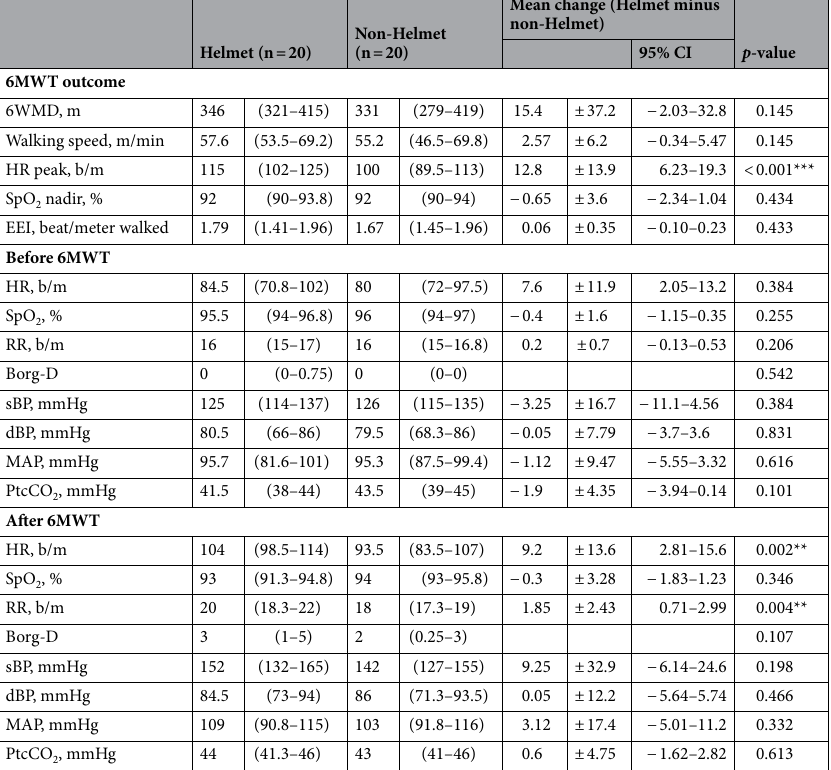
Table 2. Physiological and 6MWT outcomes. Data are presented as mean ± SD or median (IQR). ** p < .01; *** p < .001. 6MWT 6-min walk test, 6WMD 6-min walk distance, HR heart rate, SpO 2 oxygen saturation, EEI energy expenditure index, RR respiratory rate, Borg-D Borg dyspnea score, sBP systolic blood pressure, dBP diastolic blood pressure, MAP mean arterial pressure, PtcCO 2 transcutaneous carbon dioxide